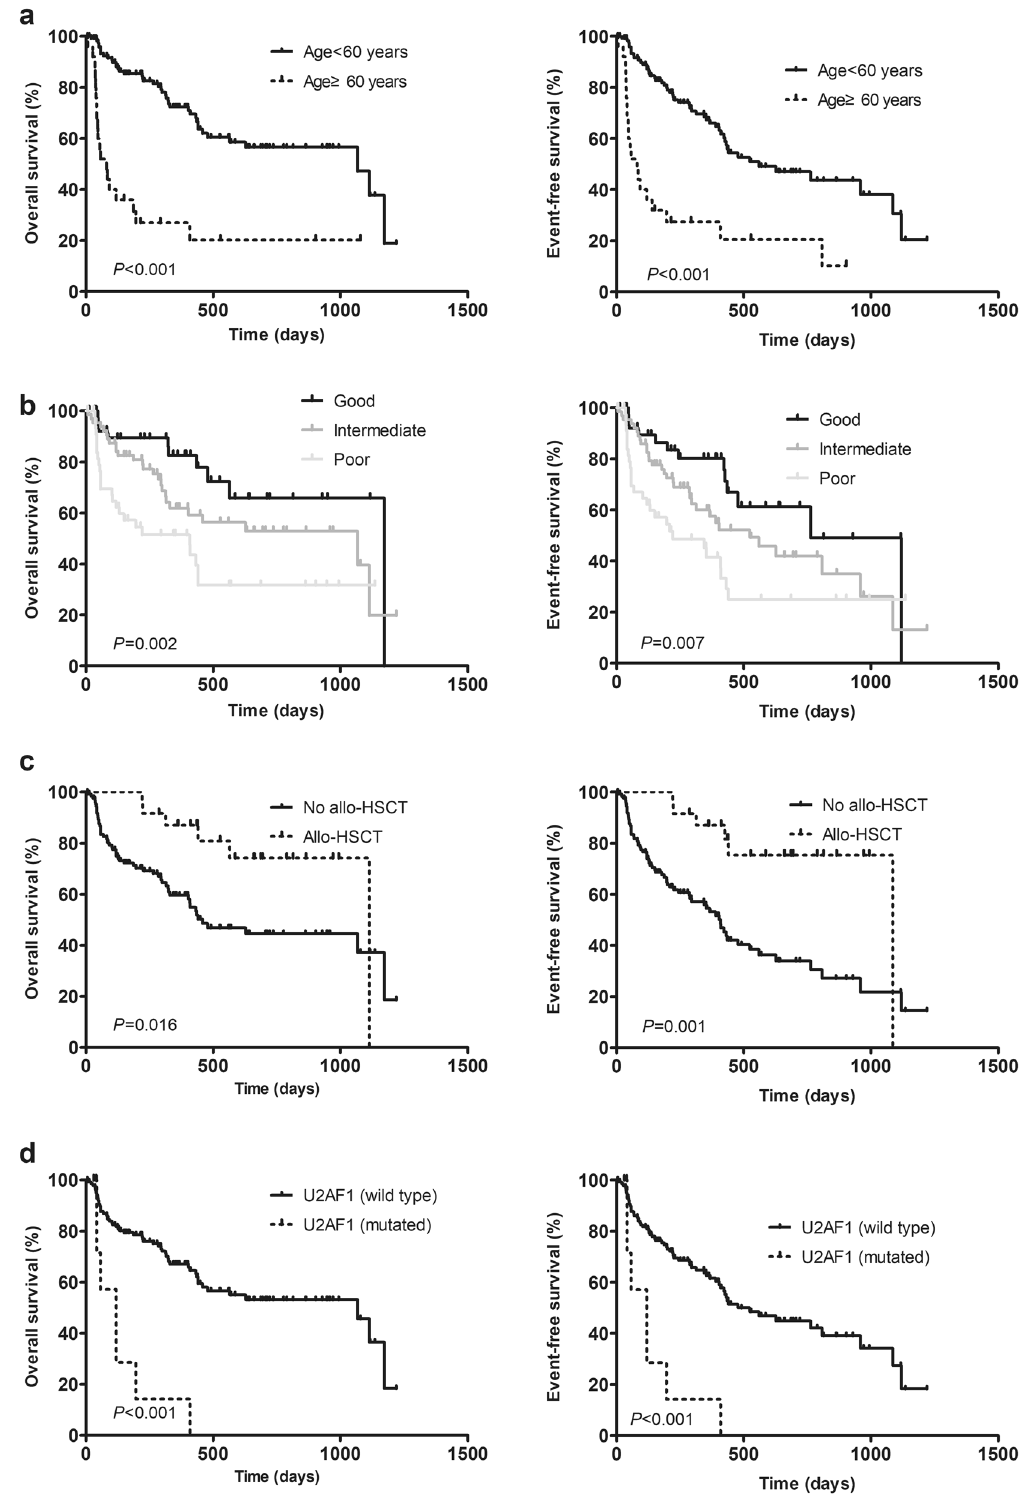
Figure 3. Kaplan–Meier estimate of overall survival (OS) and event-free survival (EFS) in 152 NRAS mut AML. OS and EFS were compared in ( a ) patients older than 60 years and patients younger than 60 years ( b ) different risk groups ( c ) patients who accepted allo-HSCT or not (d) patients with U2AF1 mutations or